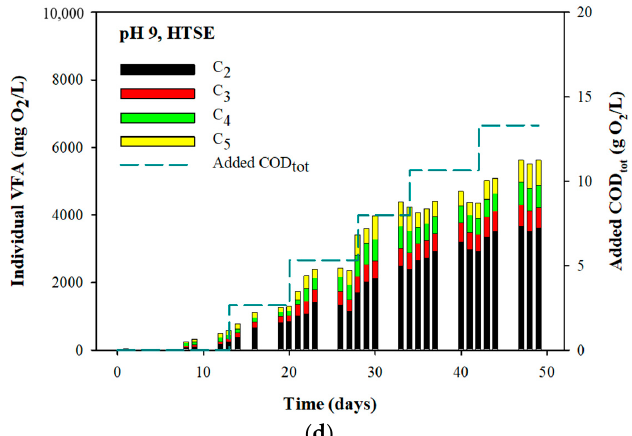
Figure 4. Individual VFA compounds, i.e., acetic acid, propionic acid, butyric acid, and valeric acid accumulated for ( a ) pH5 SE, ( b ) pH5 HTSE, ( c ) pH 9 SE, and ( d ) pH9 HTSE against the accumulated added substrate (added COD tot ) throughout the experimental time.